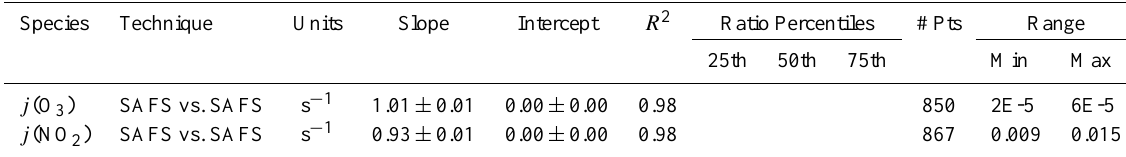
Table 3f. Statistical results of DC-8/C-130 intercomparison. j -values. NOTE: Technique is listed as X (C-130) vs. Y (DC-8). Species